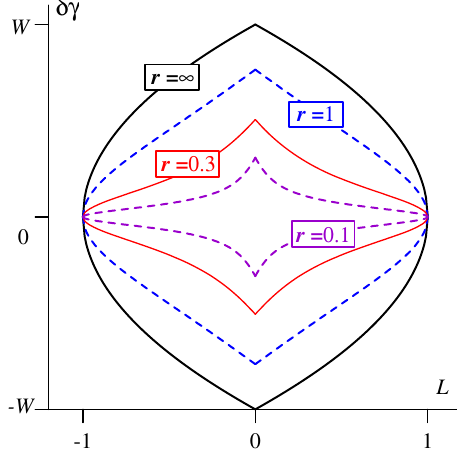
FIG. 5. The model of an electron bunch consisting of two particles. Phase planes describing the evolution of the bunch in the negative-mass undulator at different factors of the transverse inhomogeneity r